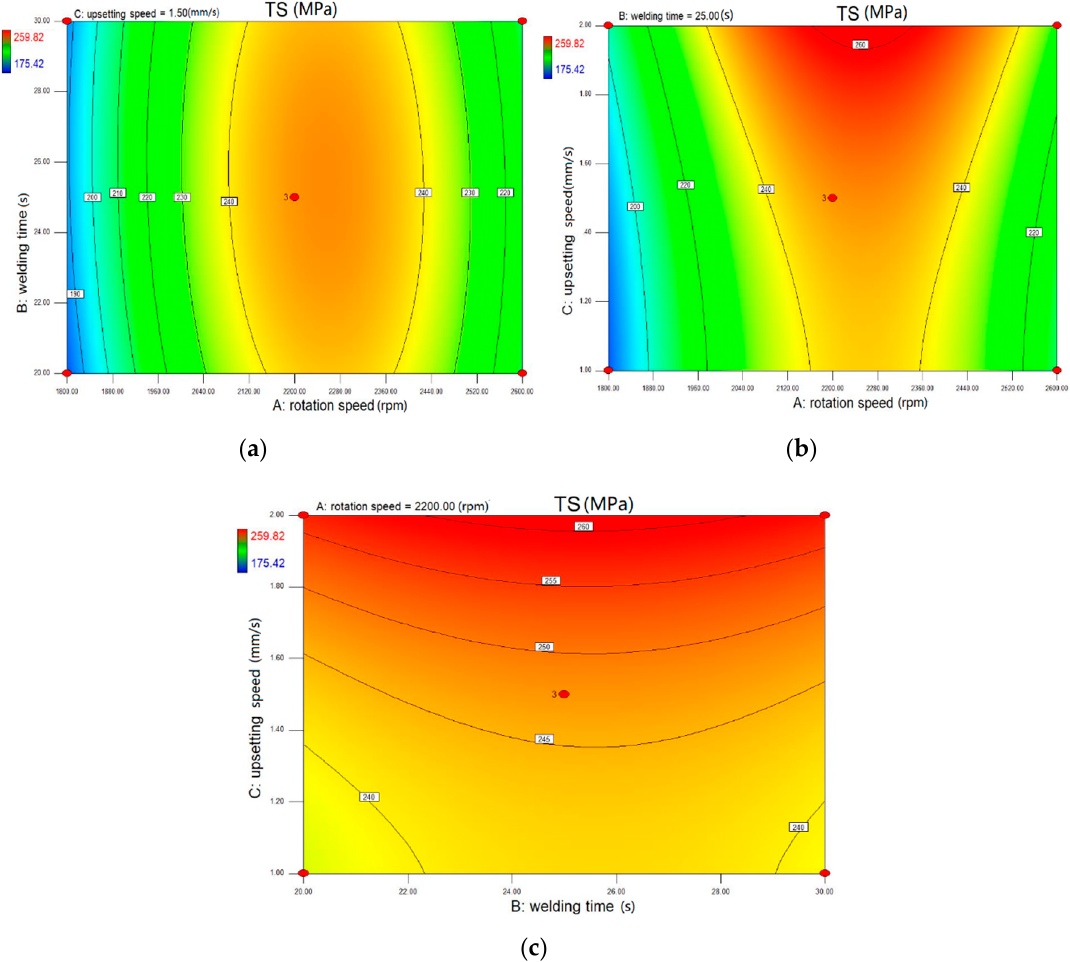
Figure 4. Contour plots showing the effect of the parameters on the tensile strength of the FPW joints: ( a ) interaction effect of the rotational speed and welding time, ( b ) interaction effect of the rotational speed and upsetting speed, and ( c ) interaction effect of the upsetting speed and welding time. Table 5. ANOVA table for the response, tensile strength.